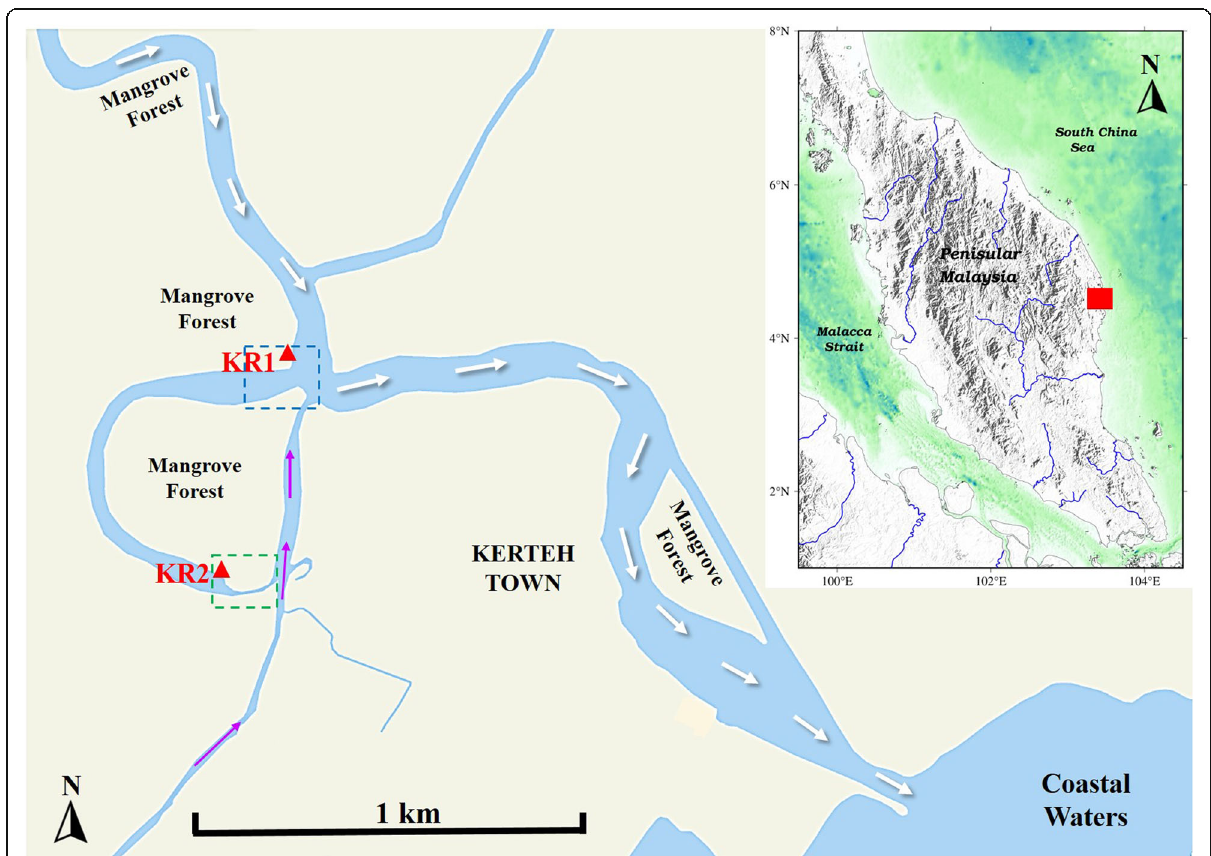
Fig. 1 Map showing the Kerteh mangrove forest in Peninsular Malaysia and the locations of cores KR1 (4° 31 ′ 27. 5" N, 103° 26 ′ 25.91" E) and KR2 (4° 31 ′ 10.98" N, 103° 26 ′ 19.68" E). The white arrows indicate the river flow directions of main water body of Sungai Kerteh from upstream toward the tidal channel and pink arrows indicate the river flow direction from small branch of Sungai Kerteh. The blue dash box indicates the cutoff location and the pale green dash box indicates new mangrove vegetation at the old river ’ s pathway due to the active sedimentation process (source: Google